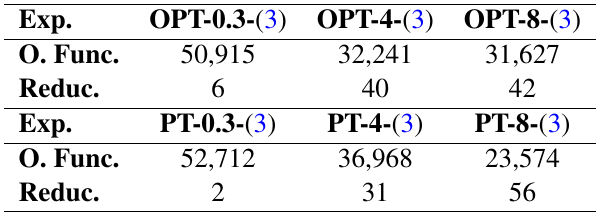
Table 1 Objective function (3) value ( O. Func. ) expressed in tons of oil and the percentage of oil pumped ( Reduc. ) given by the experiments ( Exp. ): OPT-0.3- (3), OPT-4- (3), OPT-8- (3), PT-0.3- (3), PT-4- (3) and PT-8- (3)